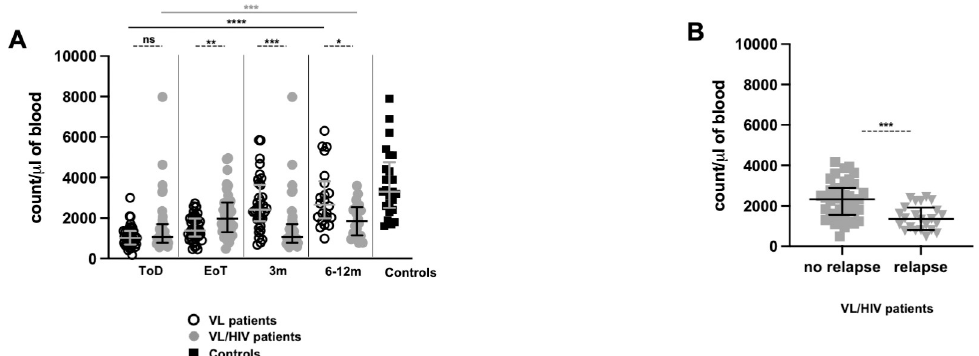
Fig 1. Comparison of neutrophil counts between VL and VL/HIV patients and controls over time. Neutrophil counts were measured in the whole blood of controls (n = 25), VL (ToD: n = 41, EoT: n = 42; 3m: n = 34, 6-12m: n = 22) and VL/ HIV (ToD: n = 37, EoT: n = 36, 3m: n = 37, 6-12m: n = 20) patients as described in Material and Methods. A. Comparison of neutrophil counts over time in VL, VL/HIV and controls. B. Comparison of neutrophil counts from VL/HIV patients who did not relapse (n = 39) and those who relapsed (n = 23) after successful anti-leishmanial treatment, during the 3m and 6–12 follow-up period. If a patient did not relapse during the two-time points of follow-up and if a patient relapsed at both 3 and 6–12 months, this is represented as 2 measurements. Each symbol represents the value for one individual. Results are presented as median with interquartile range. Statistical differences between VL and VL/HIV patients at each time point or between VL/HIV patients who did not relapse and those who relapsed were determined using a Mann- Whitney test and statistical differences between the 4 different time points for each cohort of patients were determined by Kruskal-Wallis test. ToD = Time of Diagnosis; EoT = End of Treatment; 3m = 3 months post EoT; 6-12m = 6–12 months post EoT. ns = not significant.